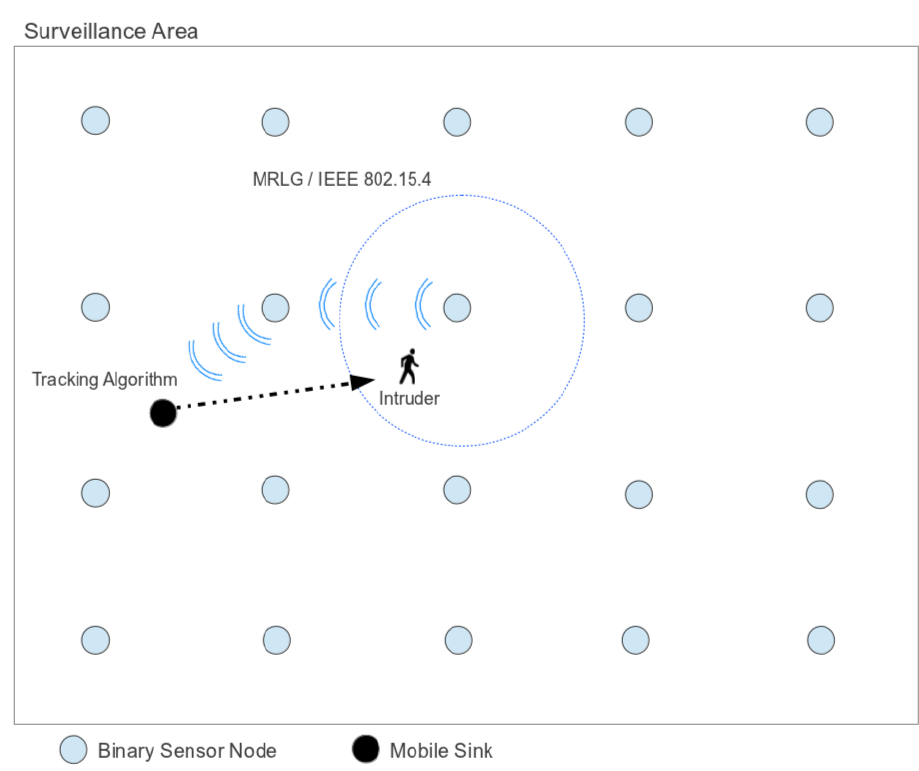
Figure 1. Architecture of the proposed